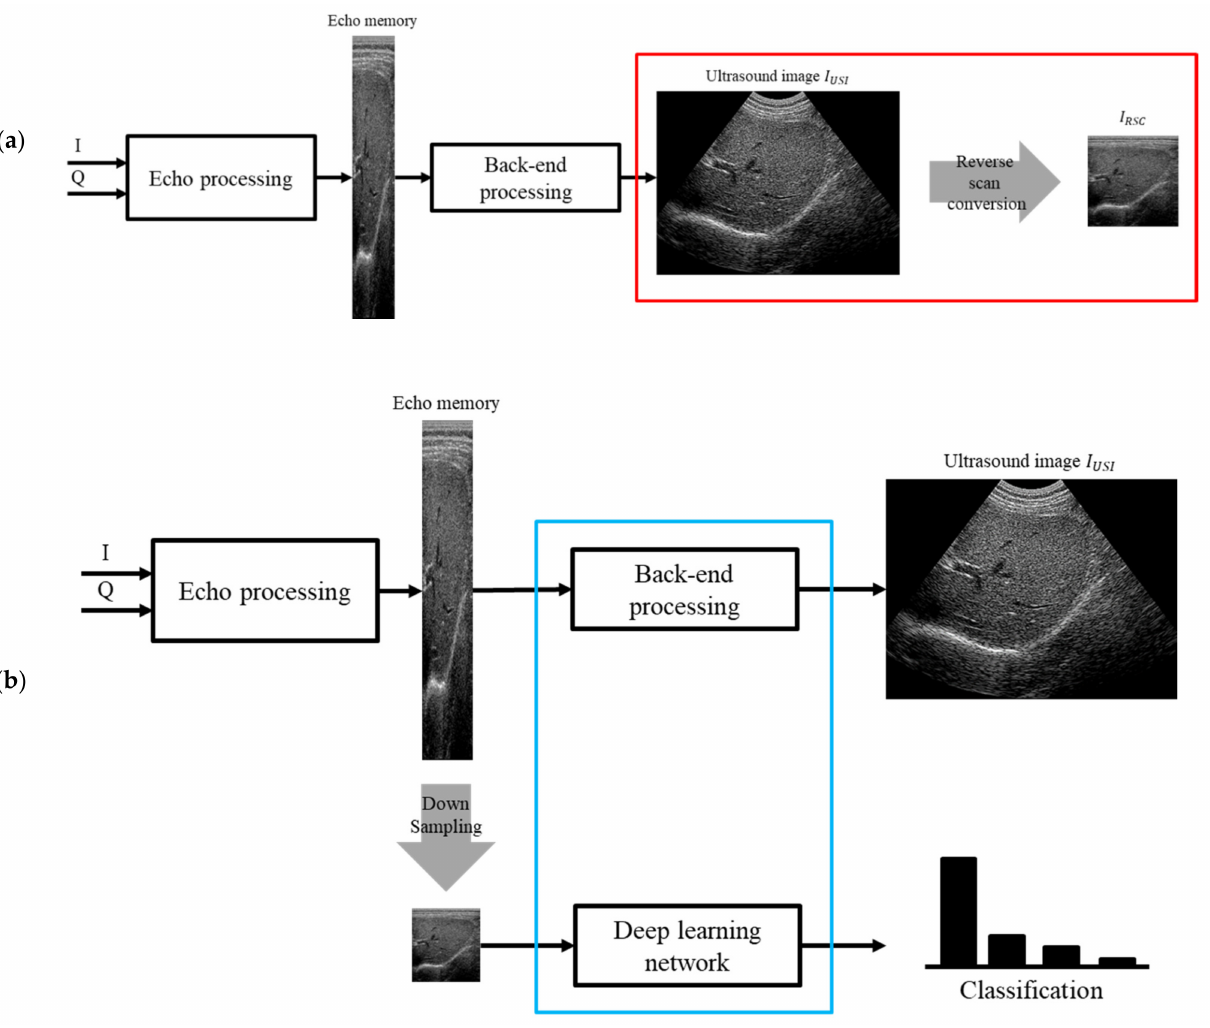
Figure 3. ( a ) Ultrasound image formation processing structure and reverse scan conversion training data building procedure using I USI , echo memory data (red box). ( b ) For real-time ultrasound imaging and inference, we propose a blue box structure that can effectively compute back-end processing and the deep learning network